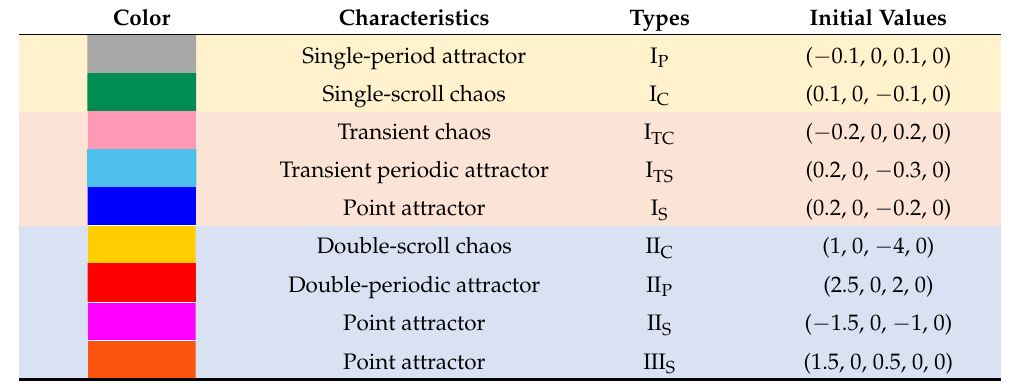
Figure 15. Basin of attraction and typical coexisting attractors under different parameters: ( a ) a 2 = 1, c 1 = 5.1, c 2 = 3.2; ( b ) a 2 = 1, c 1 = 5.7, c 2 = 3.5; ( c ) a 2 = 1.04, c 1 = 5.55, c 2 = 5.9.